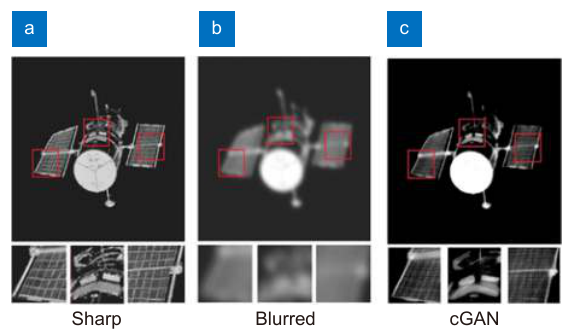
Fig. 19 | The results of blind restoration for the Hubble tele- scope. ( a ) The sharp image, ( b ) the blurred image by Zernike poly- nomial method in atmospheric turbulence strength D / r 0 = 10, and ( c ) the result of restoration by cGAN, respectively. Figure reproduced from ref. 96 , SPIE.